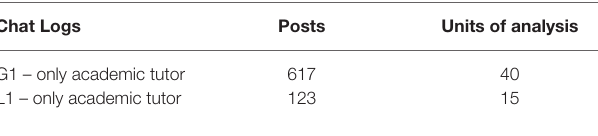
TABLE 1 | Corpus of data.